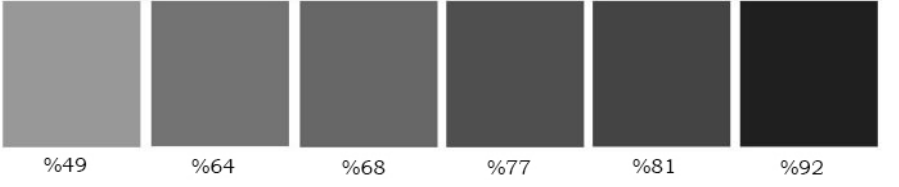
Table 1. Comparison of different GCN models configuration.